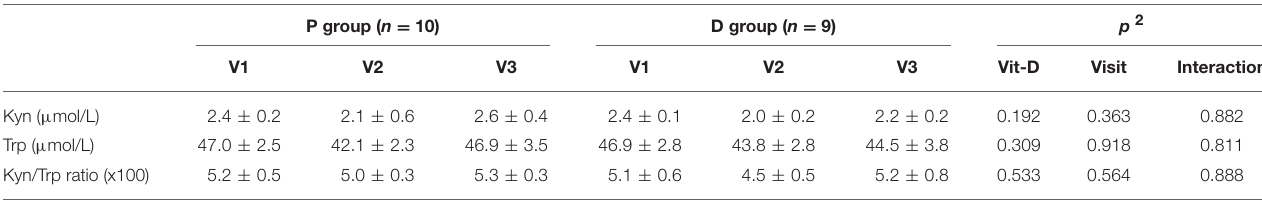
TABLE 4 | Indoleamine-2,3-deoxygenase serum activity 1